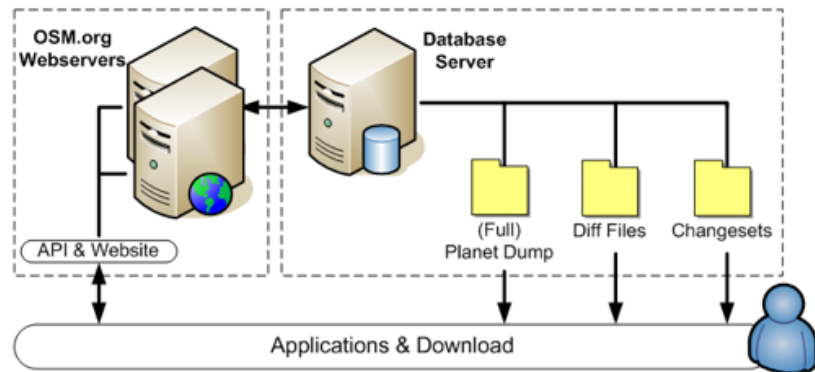
Figure 1. How to retrieve OpenStreetMap (OSM)